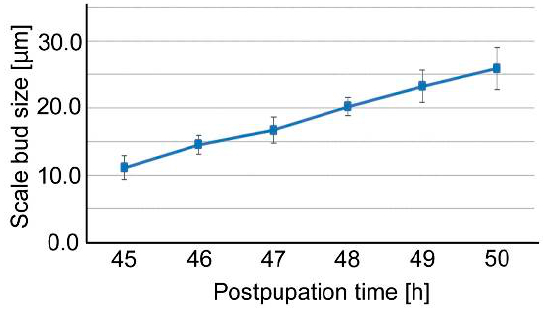
Figure 9. Size changes of the evaginating cover-scale buds. Each point and error bar indicate the mean ± standard deviation.